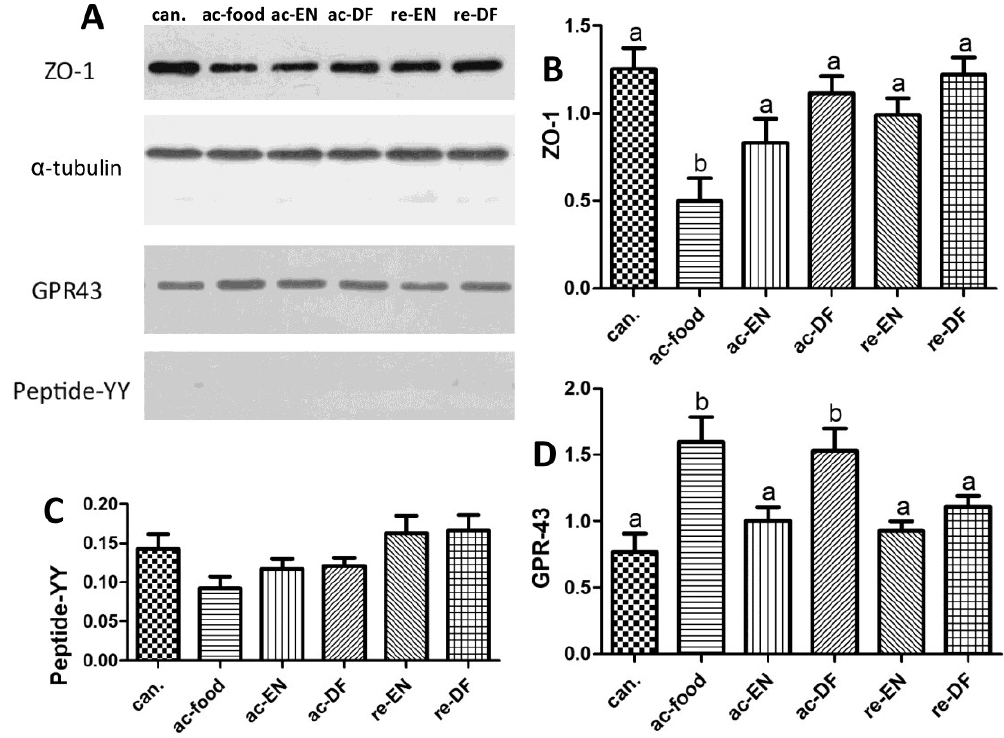
Figure 4. the amount of zonula occludens-1 (ZO-1), G protein-coupled receptor 43 (GPR43) and Peptide-YY in the mucosa and the amount of GPR43 in the White blood cells (WBC). The expression of ZO-1 (can. 1.25 ± 0.27, ac-food 0.50 ± 0.29, ac-EN 0.83 ± 0.30, ac-DF 1.12 ± 0.22, re-EN 0.99 ± 0.21, and re-DF 1.22 ± 0.22), GPR43 (can. 0.77 ± 0.31, ac-food